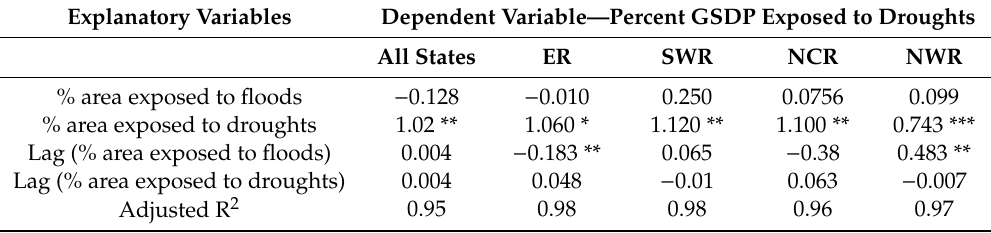
Table 4. Statistical significance of the relationship of drought exposed areas and GSDP. Explanatory